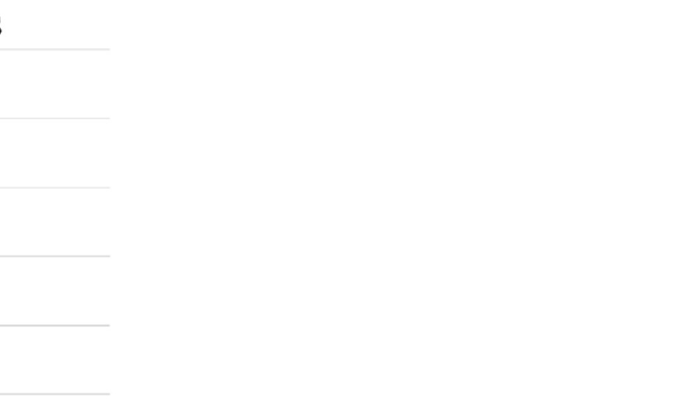
Figure 6. The VAS scores after the first LEX exercise. LEX, leg exercise apparatus; VAS, visual analog scale. As for fatigue after the first LEX, the mean Borg scale score was 13 (range, 7–19) (Figure 7).